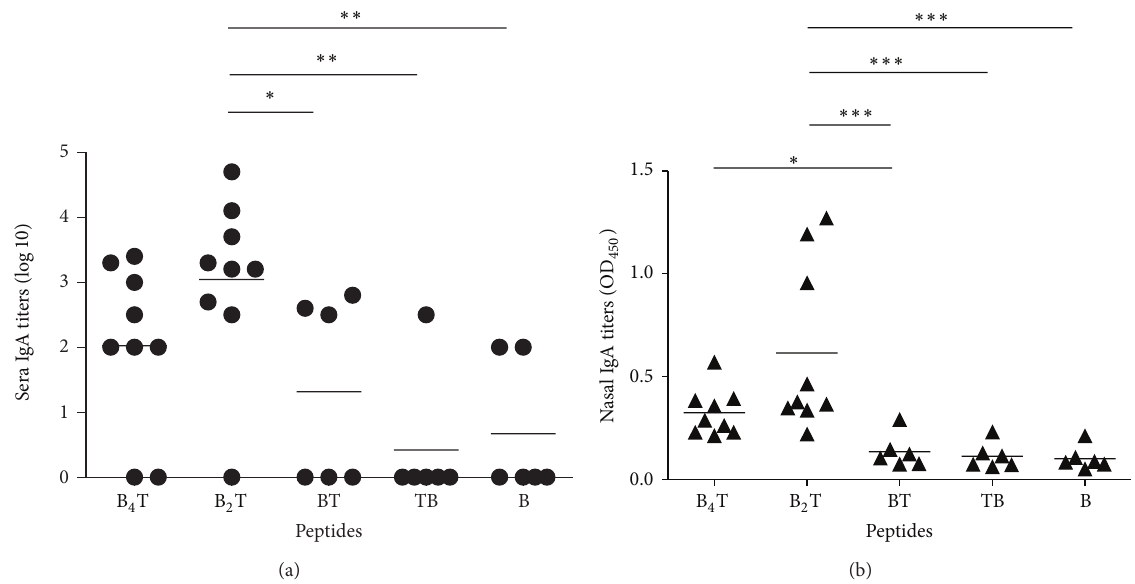
Figure 4: Systemic (serum) and local (nasal) IgA antibody responses to FMDV determined by ELISA at day 39 postimmunization. (a) IgA antibody titers against FMDV. Endpoint titers were expressed as described in Figure 3. Each symbol represents the value for an individual mouse. Horizontal lines indicate the mean value for each group of animals. (b) IgA antibody titers against FMDV determined in nasal fluids. Titers are expressed as the OD at 450 nm value obtained using a 1:10